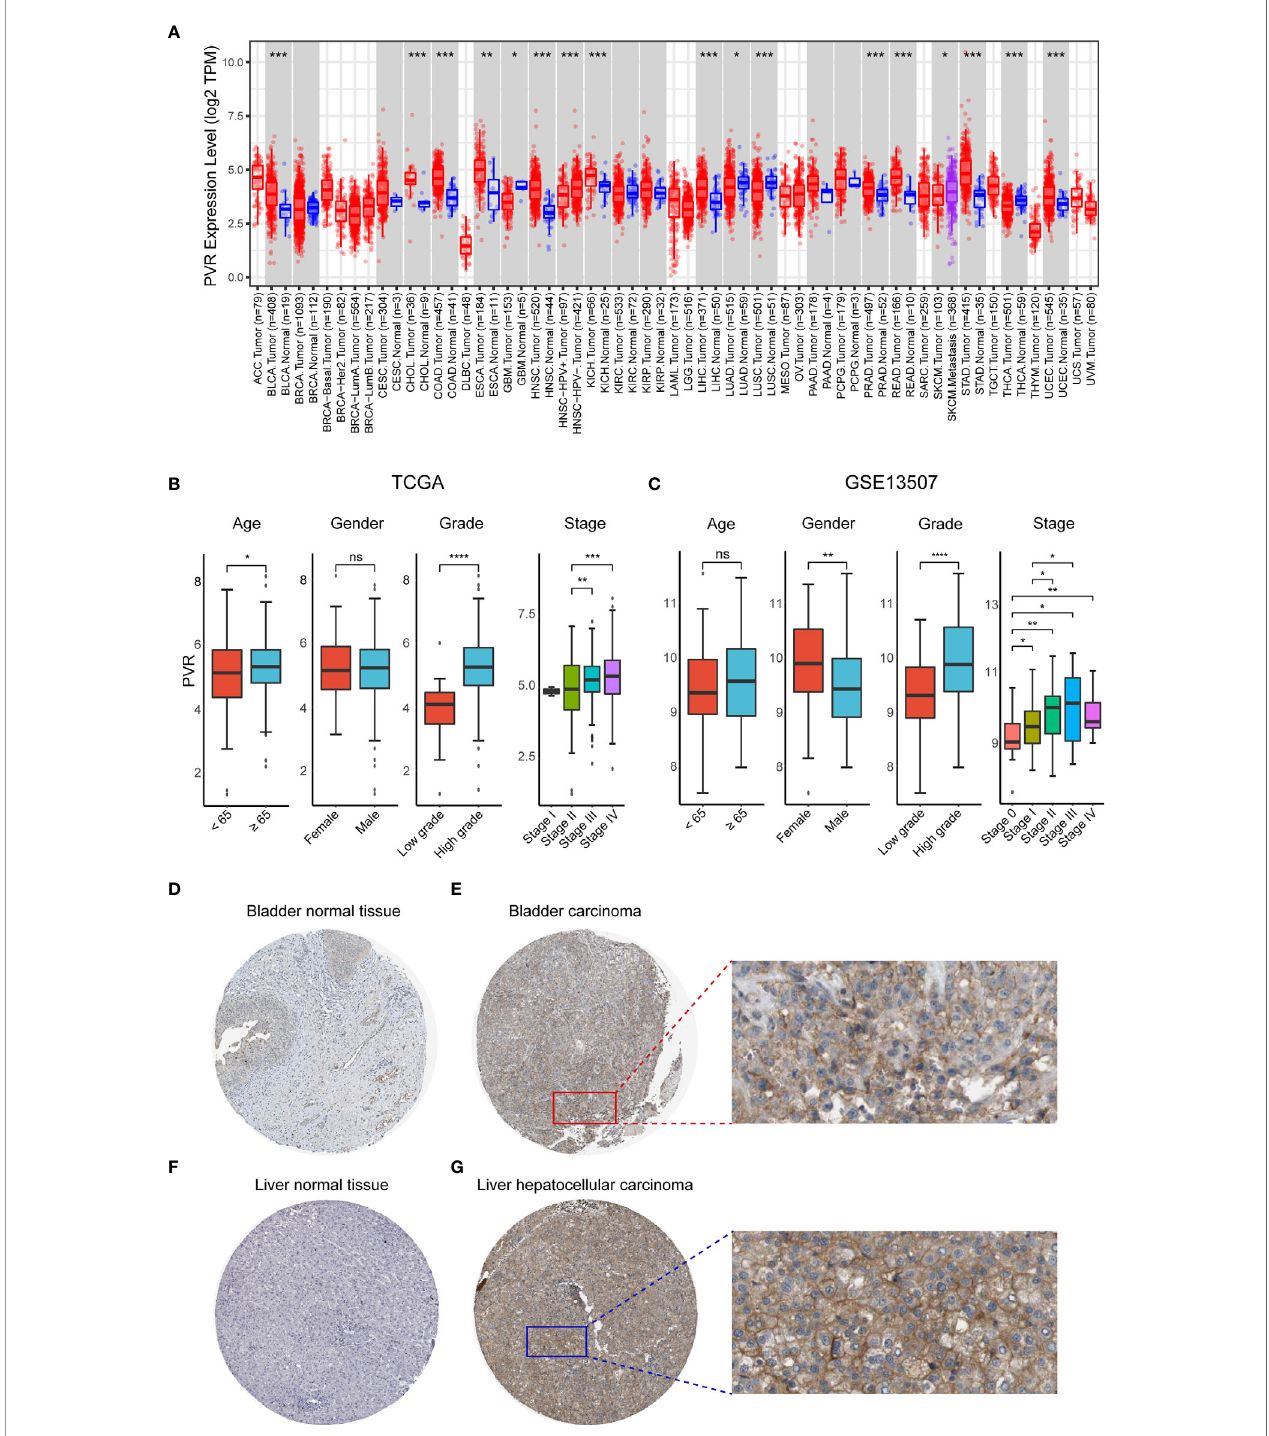
FIGURE 1 | PVR expression pro fi les in human normal and cancer tissues. (A) PVR expression levels in different tumor types from TCGA database were analyzed by TIMER2.0 (* P < 0.05, ** P < 0.01, *** P < 0.001). (B, C) The PVR expression of different subgroups for age, gender, WHO grade, pathologic stage in TCGA and GSE13507 cohorts. (D – G) Representative IHC images of PVR protein expression in bladder normal tissues, bladder carcinoma tissues, liver normal tissues, and hepatocellular carcinoma tissues, respectively. ****P < .0001. ns, not signi fi cant.